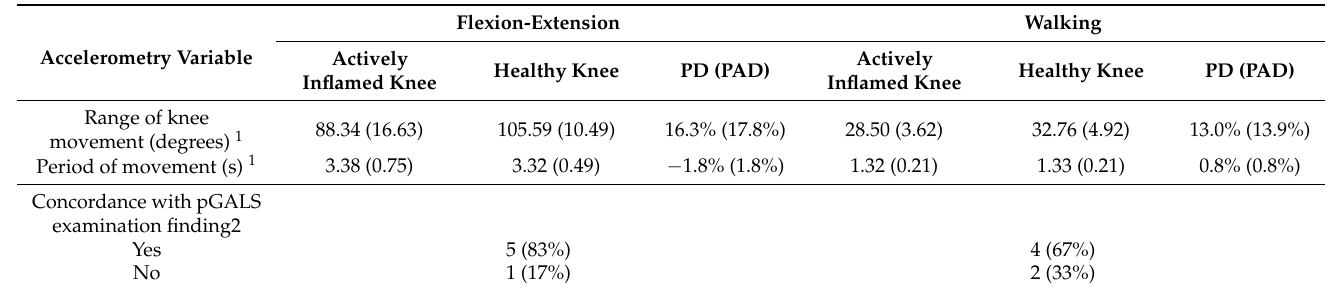
Table 3. Summary statistics for knee range of movement and period of movement, and the concord ‐ ance with pGALS examination findings.